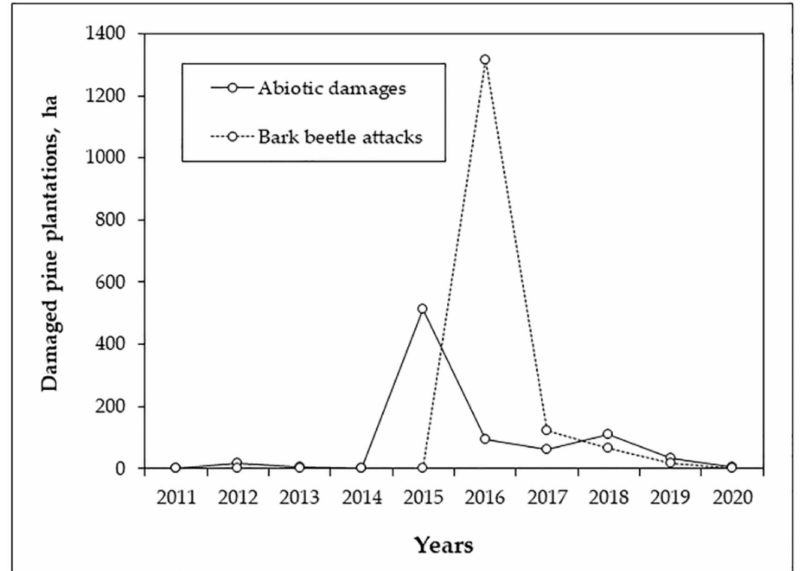
Figure 5. Damage caused by bark beetles in pine plantations in the region of SF